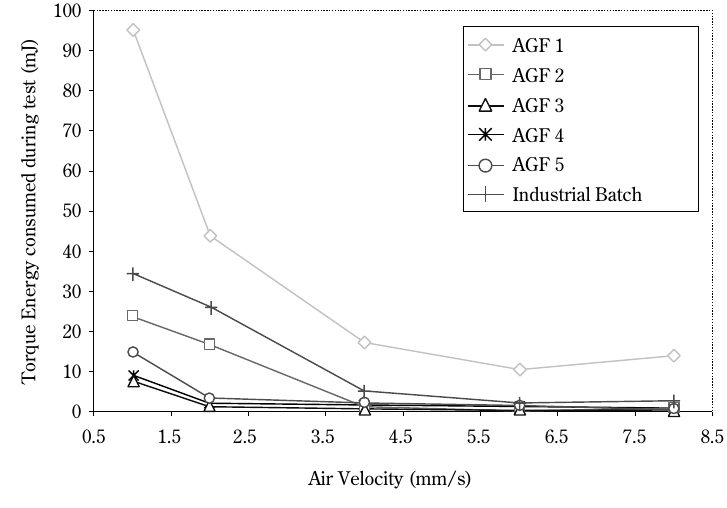
Fig. 13 Energy as a function of aeration air